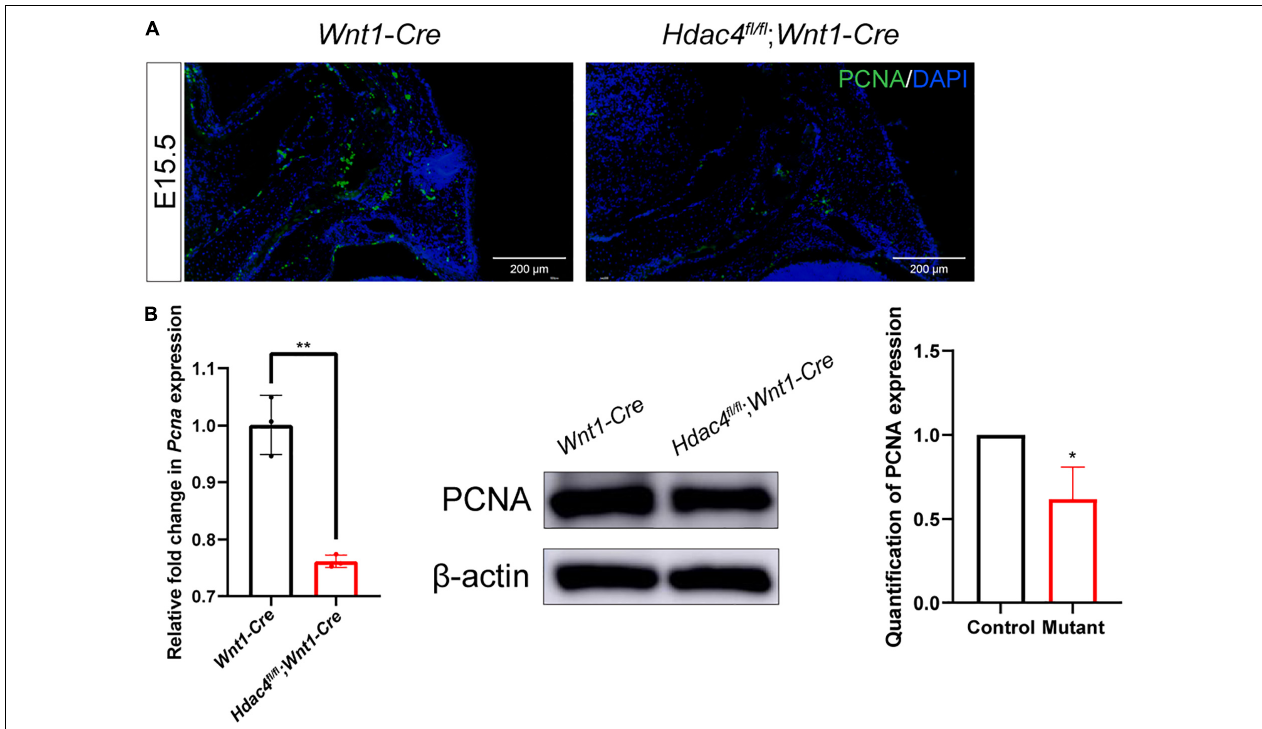
FIGURE 6 | (A) Immunofluorescence staining of PCNA in the frontal bone of control and Hdac4 fl / fl ;Wnt1-Cre mutant mice at P0. (B) RT-qPCR analysis and western blotting of PCNA in the frontal bone of control and Hdac4 fl / fl ;Wnt1-Cre mutant mice. * P < 0.05; ** P <